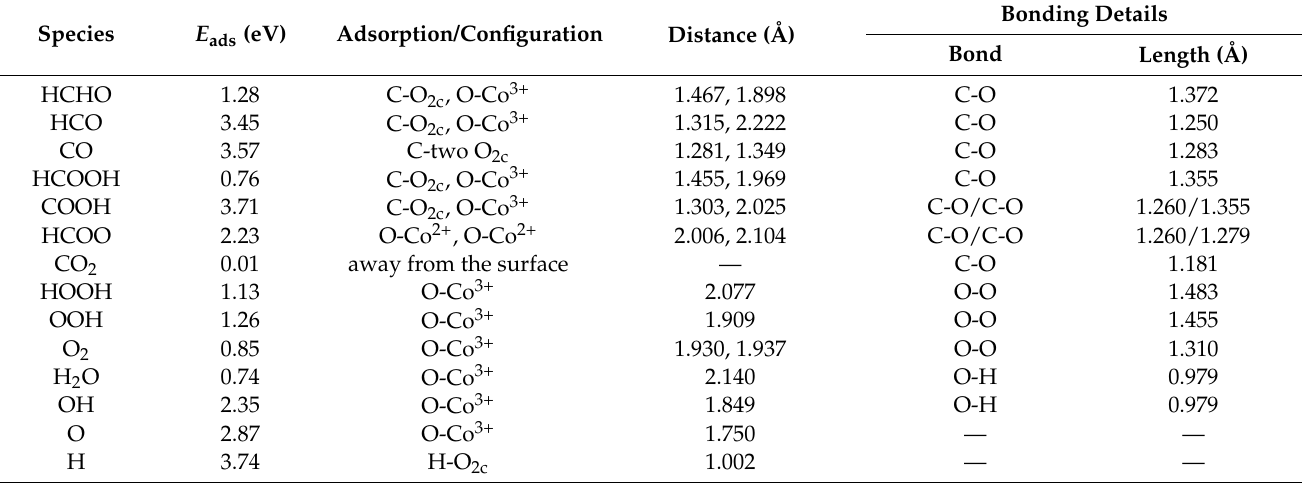
Table 1. Adsorption energies and key structural parameters of the stable configurations for the possible adsorbed species involved in HCHO oxidation to CO 2 and H 2 O on Co 3 O 4 (110)